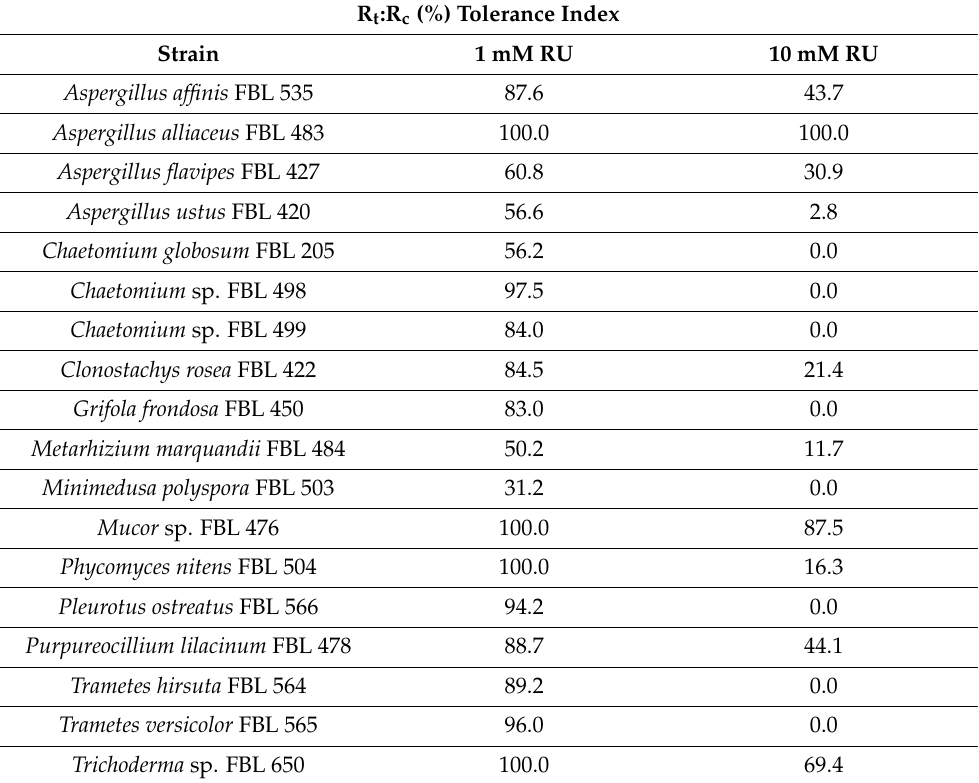
Table 3. Tolerance index (R t :R c ) of the tested species exposed to Roundup on PDA.